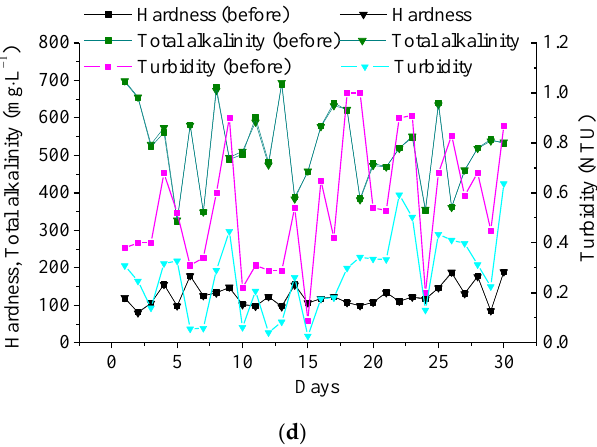
Figure 6. Pollutant changes in the primary ultrafiltration (UF) ( a ) COD cr , color, ( b ) NH 3 -N, TN, and TP, ( c ) conductivity, SO 42 − , Cl − , and ( d ) hardness, total alkalinity, turbidity .